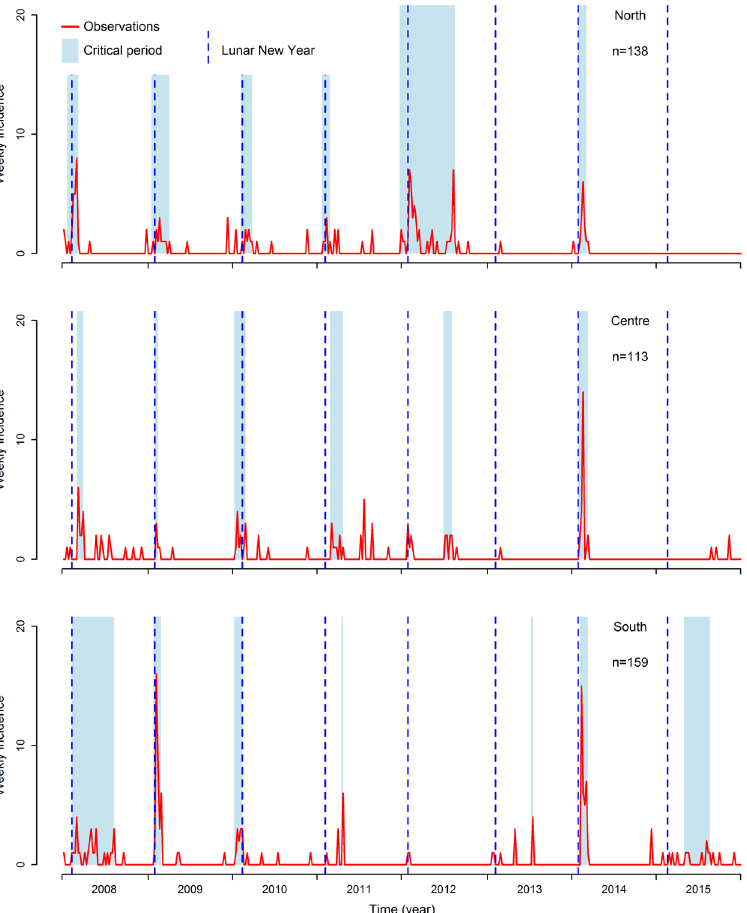
Figure 3. Weekly incidence of reported AIOs in the three climatic regions of Vietnam and estimated critical period and dates of Lunar New Year. n = number of AIOs reported in each of the climatic region during the study